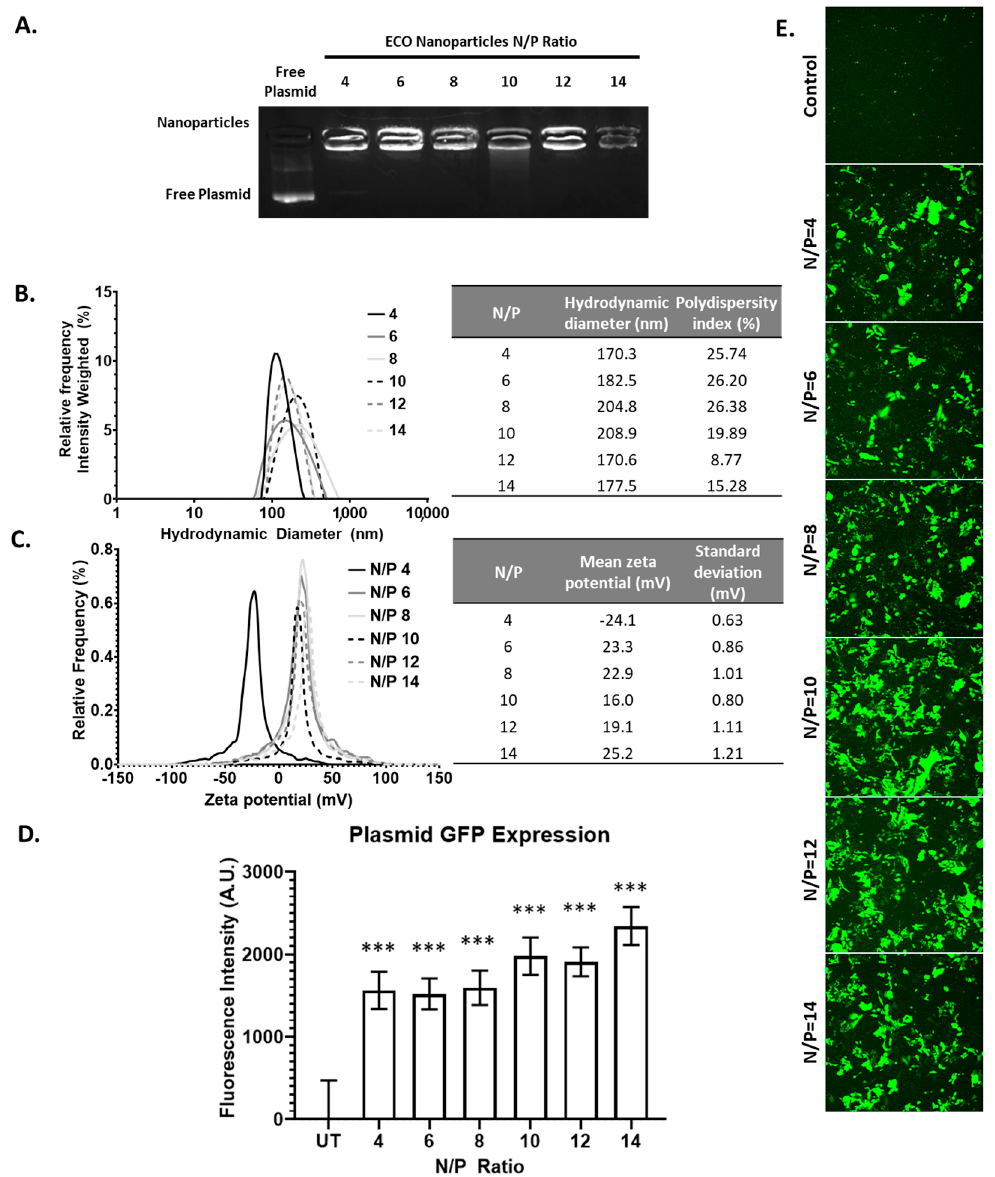
Figure 4. The ECO/pCMV-GFP characterization and transfection. ( A ) The electrophoresis of ECO/pCMV-GFP nanoparticles at N/P ratios 4–14. ( B , C ) The hydrodynamic diameter and zeta potential of the ECO/pCMV-GFP nanoparticles at various N/P ratios. ( D , E ) The GFP fluorescence intensity after 48 h of ECO/pCMV-GFP nanoparticles transfection in ARPE-19 cells. The bars indicate mean ± s.e.m. *** p < 0.005 using an unpaired t − test.